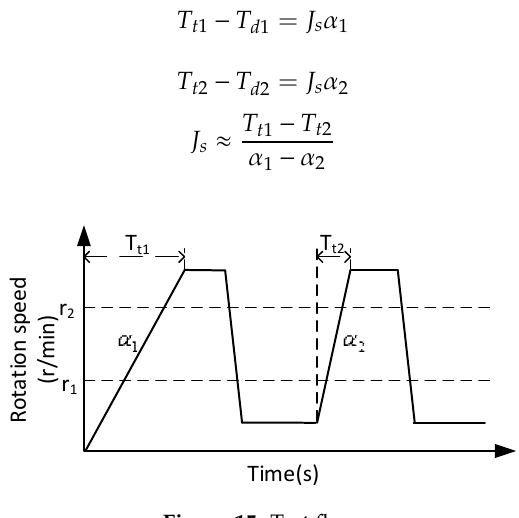
Figure 15. Test Figure 15. Test flow.